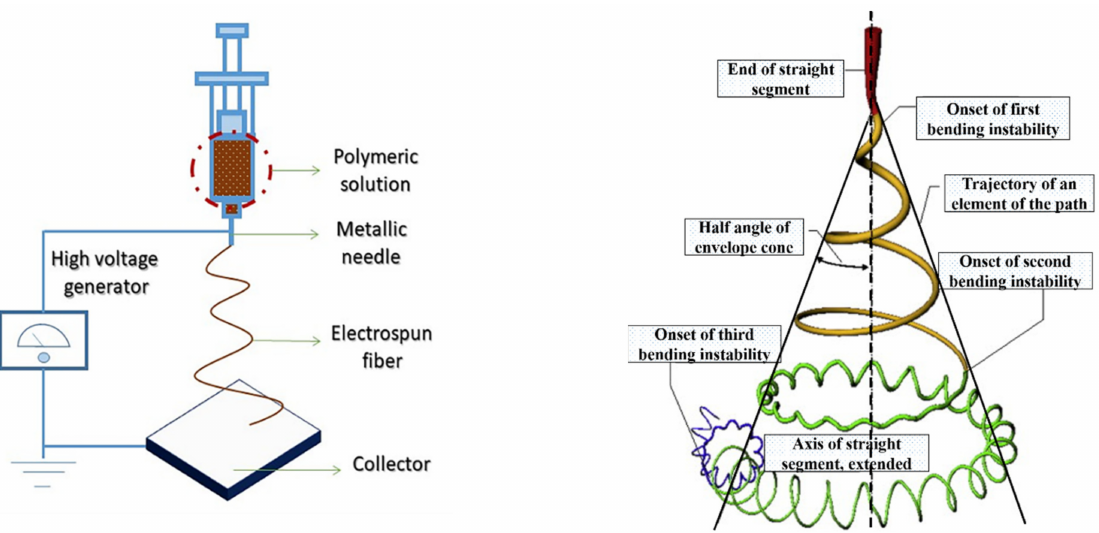
Figure 2. Schematic representation of the ES process. Reprinted with permission from Ref. [27]. 2020, Elsevier.